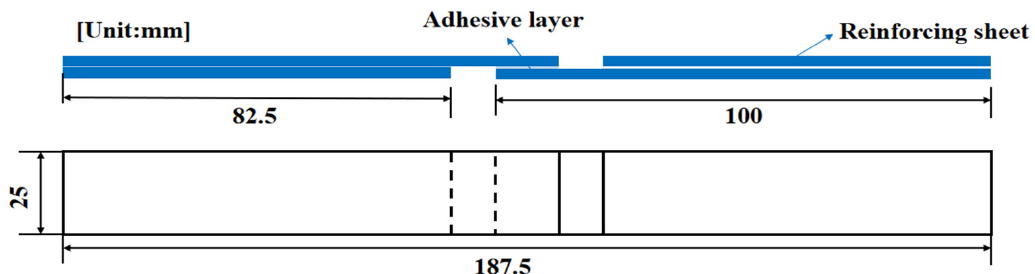
Figure 2. Schematic diagram of single-lap specimen.